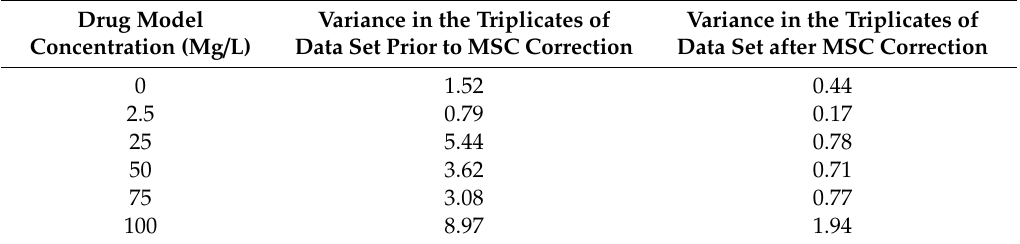
Table 2. Variance within the spectra triplicates of each experimental condition within a spectra PCA, of H. pylori treated with di ff erent concentrations of the drug